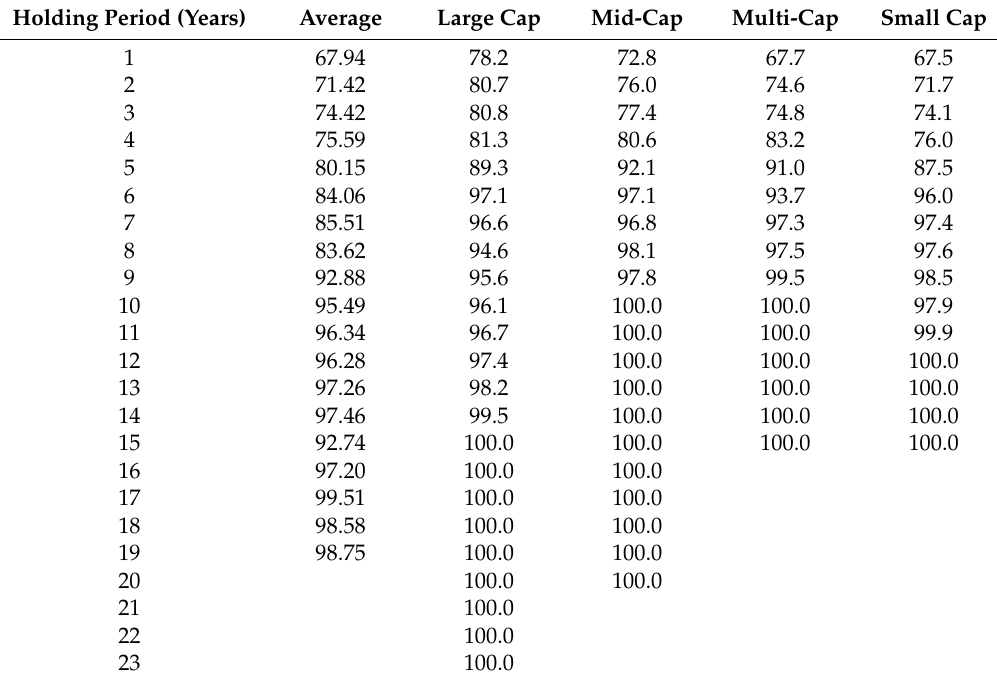
Table 6. NASDAQ ETF Success by Sector (In